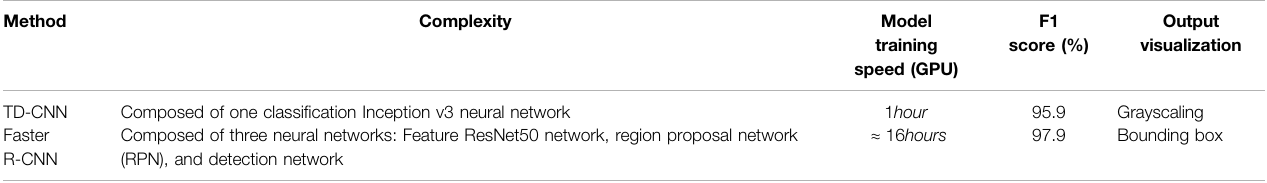
TABLE 2 | Comparison of the TD-CNN model with patches of size 128 × 128, and the off-the-shelf Faster R-CNN object detection method with subimage size of 1000 × 1000 on the tassels dataset.